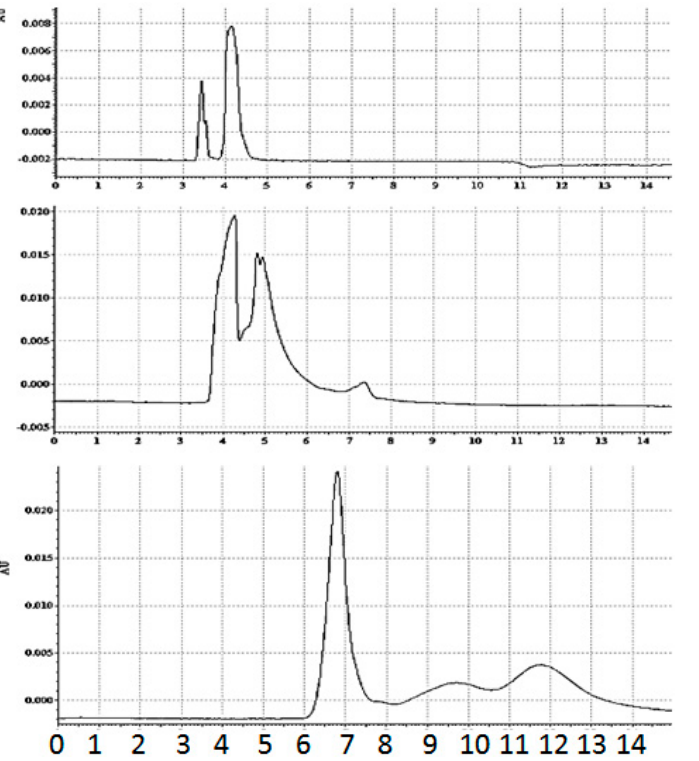
Figure 8. Capillary electrophoresis of equilibrium mixture, streptavidin/biotinylated hairpin (Bt-8gc) in presence of urea. Urea concentration increase suppresses the complex formation. Upper panel: 2.5 M urea running buffer. Sample—equilibrium mixture, no urea. Middle panel: 2.5 M urea running buffer. Sample—equilibrium mixture, 4 M urea. Left and right peaks on the two upper panels represent DNA and streptavidin-DNA complex, accordingly. The concentration of complex decreases with chaotrope concentration. In the case of 8 M urea concentration (lower panel) no complex formation is observed. The markings on the x-axes are in minutes.